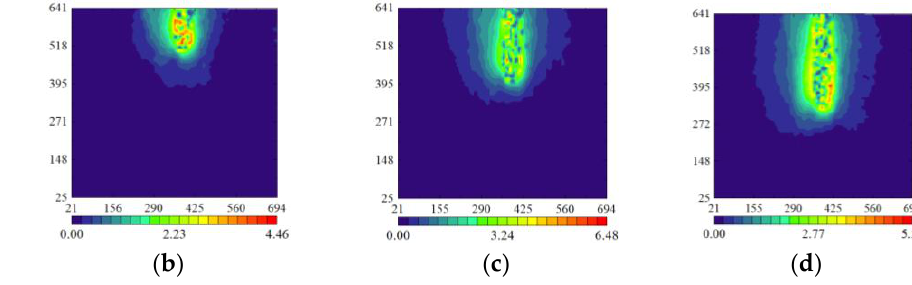
Figure 16. Cloud diagram of pipe pile penetration displacement when ( a ) penetrated into 1/4 pile length, ( b ) penetrated into 2/4 pile length, ( c ) penetrated into 3/4 pile length, and ( d ) penetrated into 4/4 pile lengths.